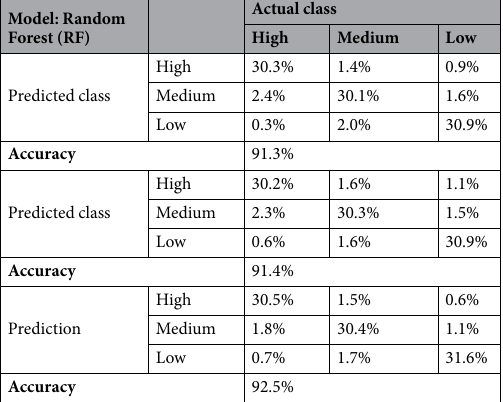
Table 3. Confusion matrix of cross validation model